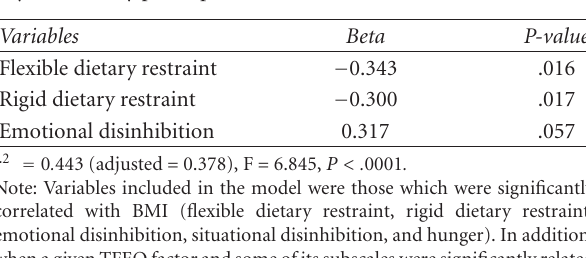
Table 4: Independent predictors of BMI in women with higher physical activity participation ( n = 49).